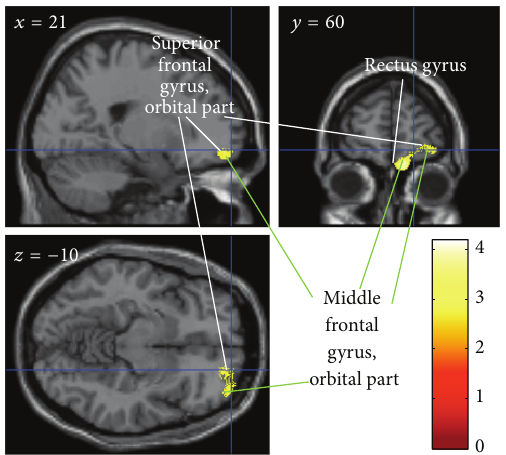
Figure 3: Effect of FSNC training on rGMV. The results are shown with 𝑃 < 0.0025 , uncorrected. Compared with the control group (no-intervention), the FSNC training group showed a significant decrease in rGMV in the right frontopolar